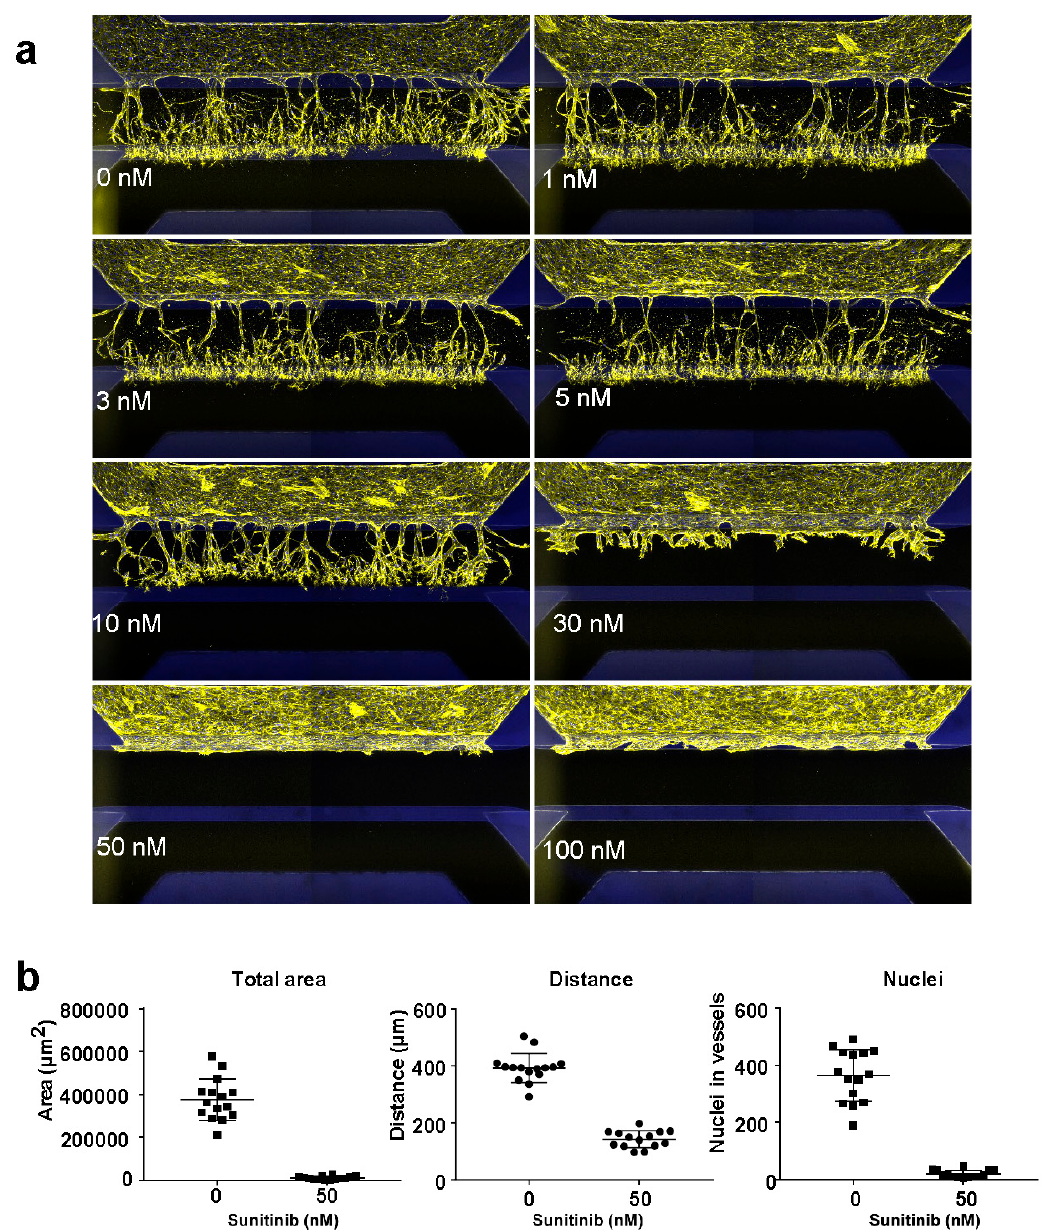
Figure 2. Concentration optimization for inhibition of angiogenic sprouting of iPSC-ECs using sunitinib. ( a ) Representative images of a concentration range of sunitinib. ( b ) Quantification of the vessel area, nuclei density and sprouting distance of maximal inhibition (50 nM) and no inhibition (control, 0 nM). Table 1. Assay performance characteristics of the quantified parameters for iPSC-ECs. The CV at maximum (CV max ) and minimum signal (CV min ) are derived from 0 nM and 50 nM respectively. Recommended values as found in Iversen et al. [23].